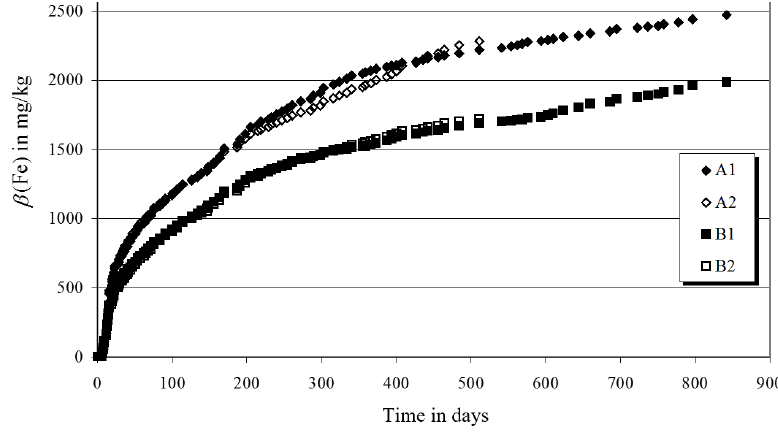
Figure 11. Cumulative mass curves of the iron extracted from the soil samples from OW II-6.